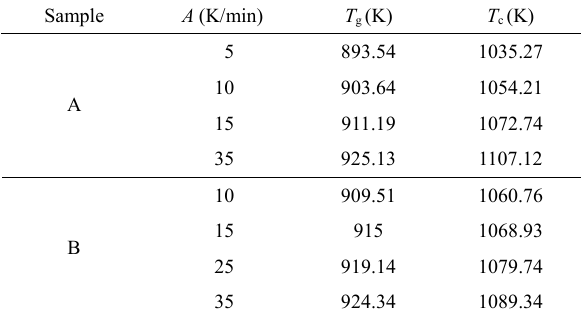
Fig. 2 DTA thermograms for (a) A and (b) B glass powders at different heating rates. Table 2 Glass transition temperature ( T g ) and the crystallization temperature ( T c ) for A and B glass powders recorded at different heating